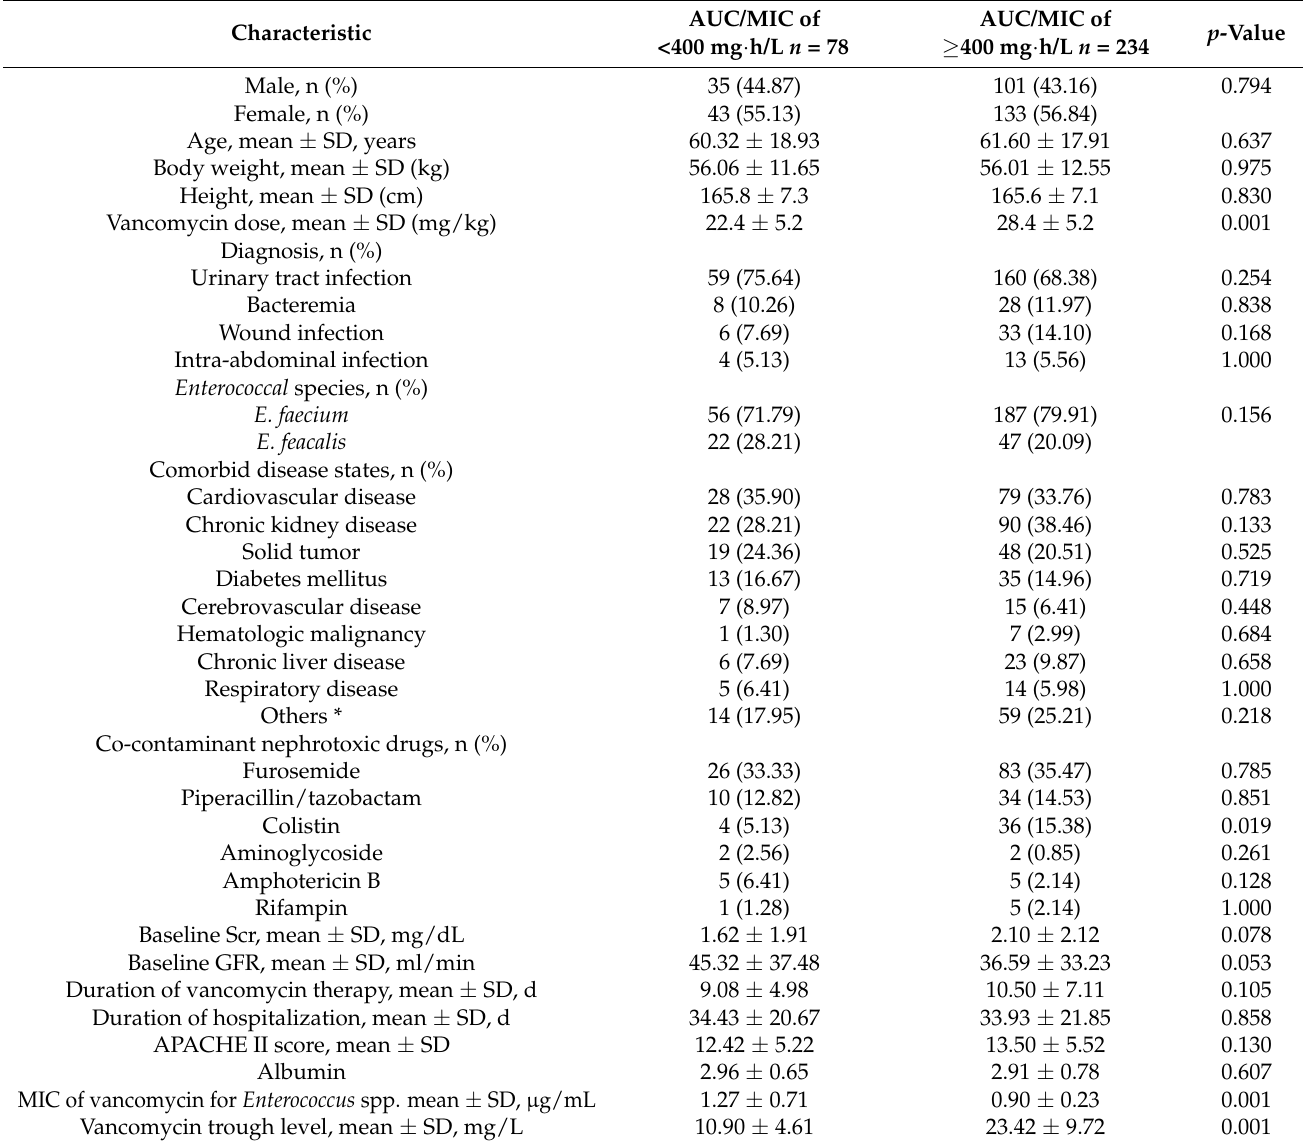
Table 1. Baseline characteristics of patients with enterococcal infection treated with vancomycin ( n = 312